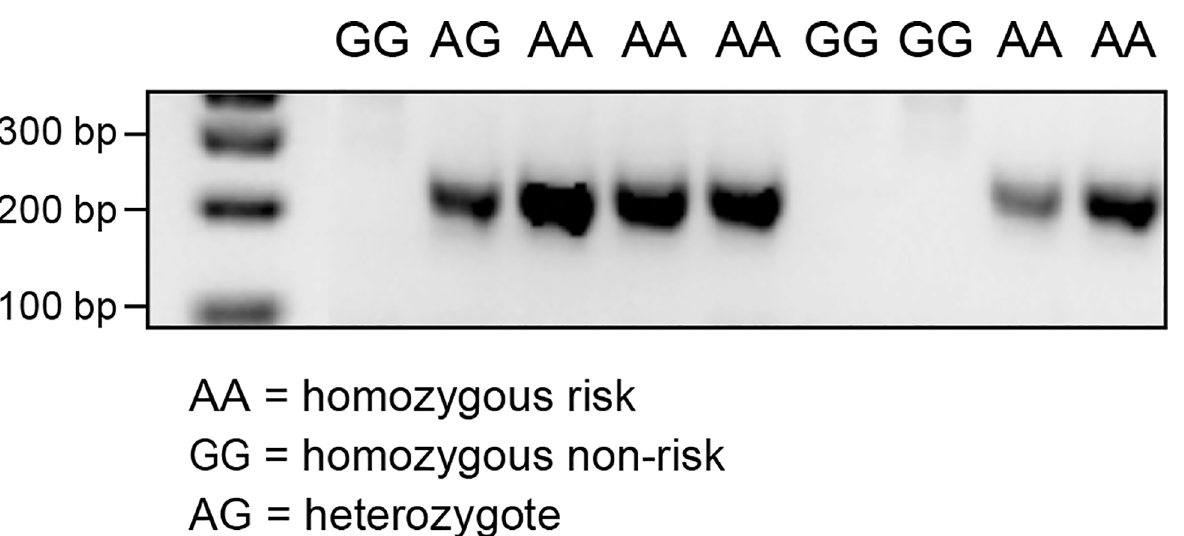
Fig 5. PCR products confirming the alternative splice site in the individuals carrying the A allele on CFA20: 42080147. PCR was performed using primers specific for the alternative splicing, excluding exon 3.